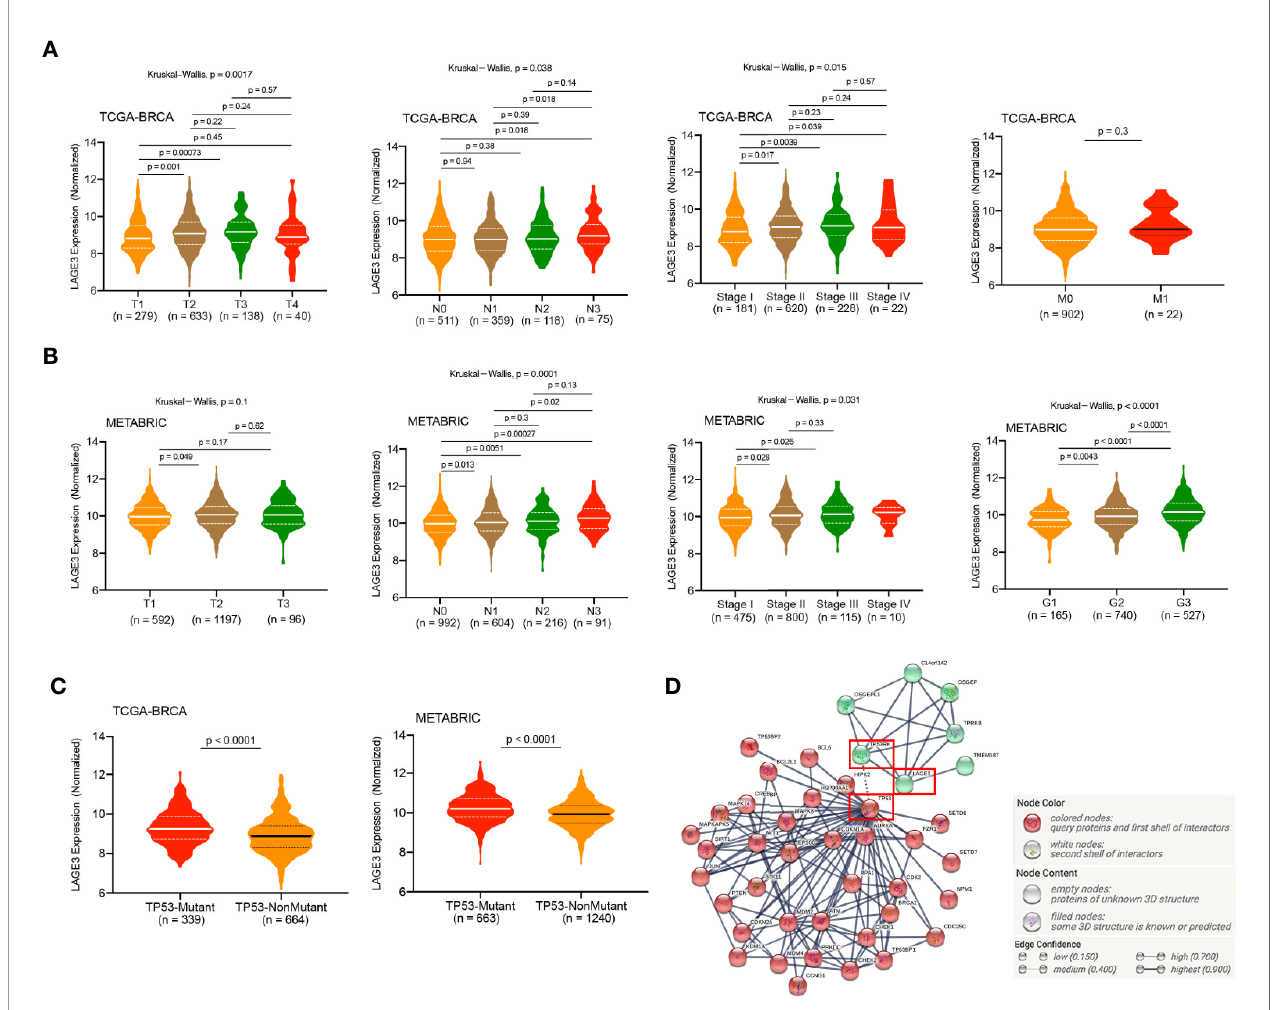
FIGURE 3 | Correlation of LAGE3 expression with clinicopathological characteristics of BC patients. (A) LAGE3 expression in the different tumor sizes, lymph node metastasis, distant metastasis, and stage subgroups in the TCGA dataset. (B) LAGE3 expression in different tumor sizes, lymph node metastasis, tumor grade, and stage subgroups in METABRIC dataset. (C) LAGE3 expression level in wild-type and mutated TP53 groups. (D) PPI network of LAGE3, TP53, and their related genes. PPI, Protein – protein